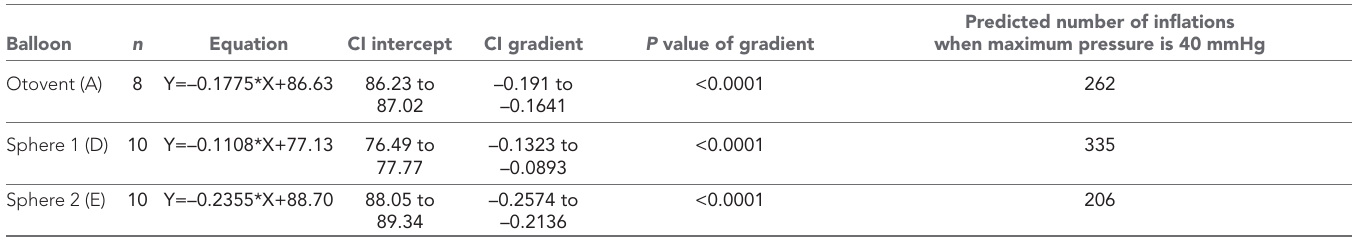
Balloon Equation CI intercept CI gradient P value of gradient